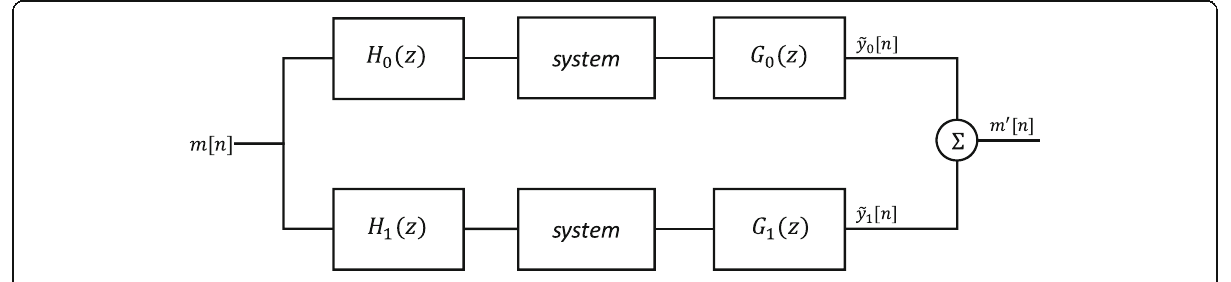
Fig. 3 Block diagram for a reconstruction two-channel filter